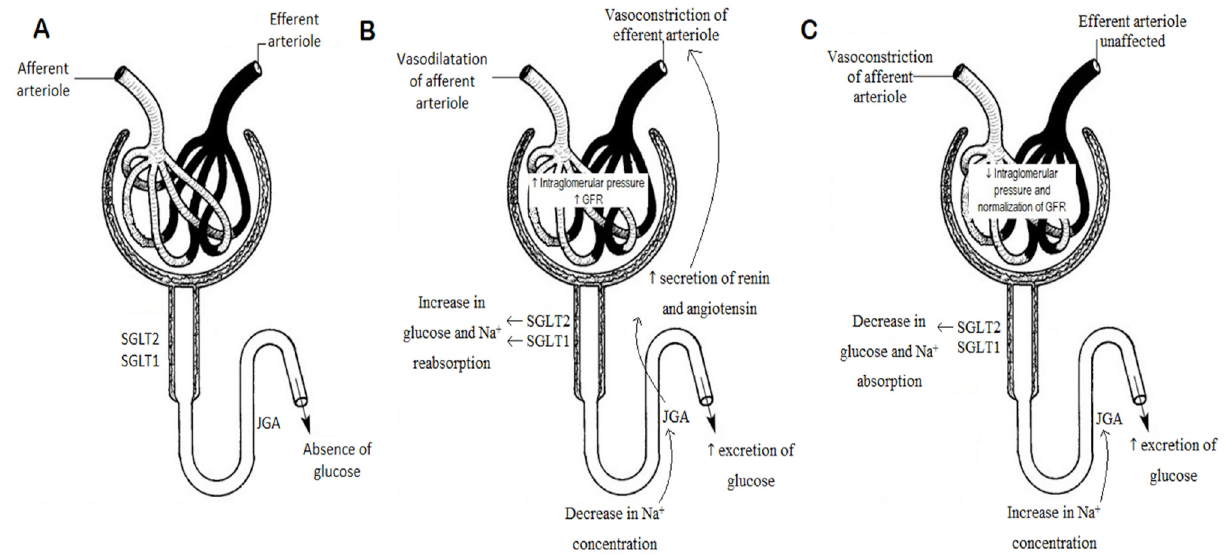
Figure 2. ( A ) Properly functioning nephron. ( B ) The mechanism of nephron impairment in the course of long-term, inappropriately treated DM. ( C ) Effect of SGLT2 inhibitor empagliflozin on improving intraglomerular pressure and GFR in DM [42]. SGLT1, SGLT2—sodium-glucose transport proteins, JGA—juxtaglomerular apparatus.